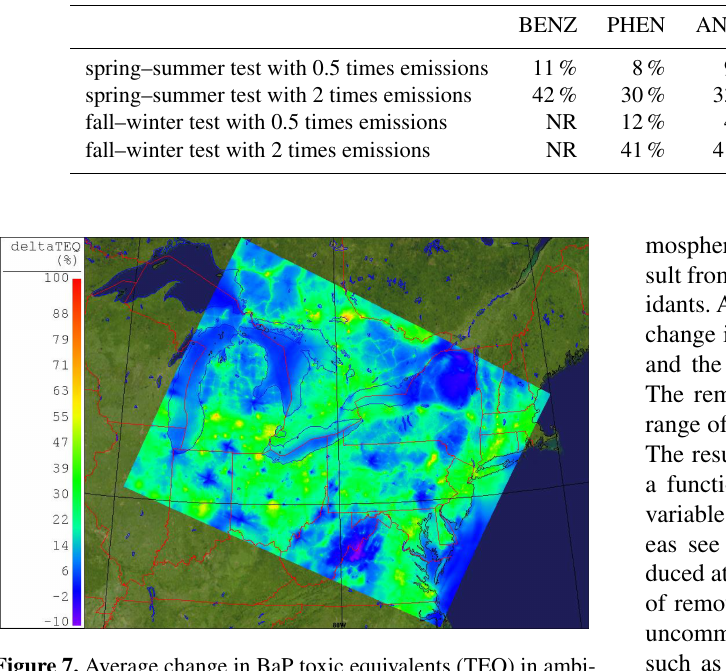
Figure 7. Average change in BaP toxic equivalents (TEQ) in ambi- ent air during spring–summer 2009 when on-road vehicle emissions are set to